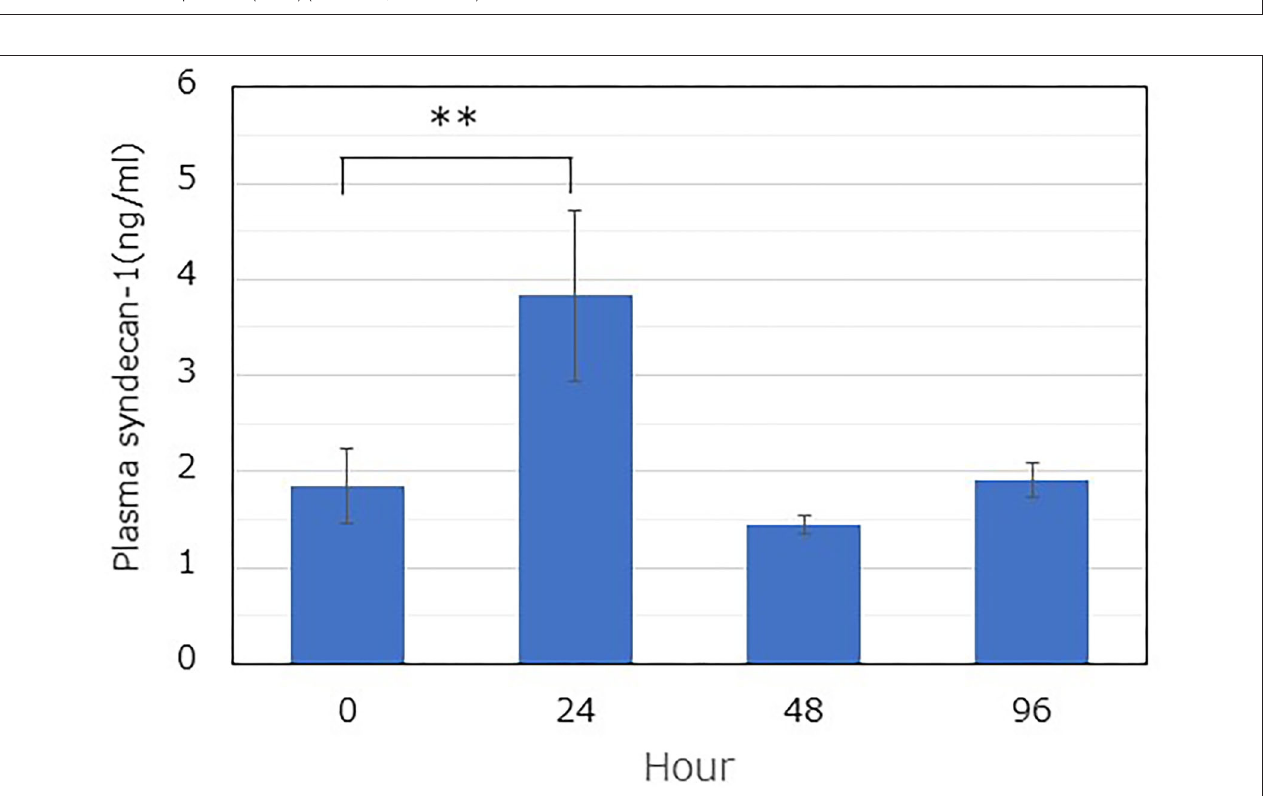
FIGURE 1 | Time dependent changes in the body weight and mean blood pressure following LPS administration. (A) The body weight was followed for up to 216h (9 days). The weight of the implanted dorsal skinfold chamber apparatus (1.5g) was excluded. Significant differences are observed at 24, 48, and 72h, compared to the value at 0h (* P < 0.05, ** P < 0.01). Each data item represents the mean ± SD ( n = 8). (B) The blood pressure was measured. Each data item represents the mean ± SD of the mean blood pressure ( n = 5) (* P < 0.05, ** P < 0.01).